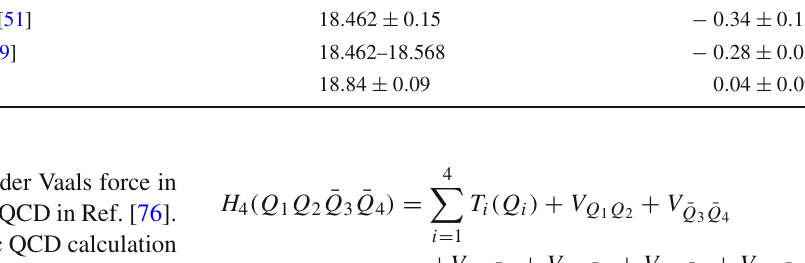
Table 1 Different theoretical predictions of masses for the ground state ( J PC = 0 ++ ) X . The acronyms NR and bb ¯ b ¯ b REL refer to nonrelativistic and relativized results, respectively. In the last column, (cid:10) ≡ m ( X ) − 2 m (η b bb ¯ b ¯ b